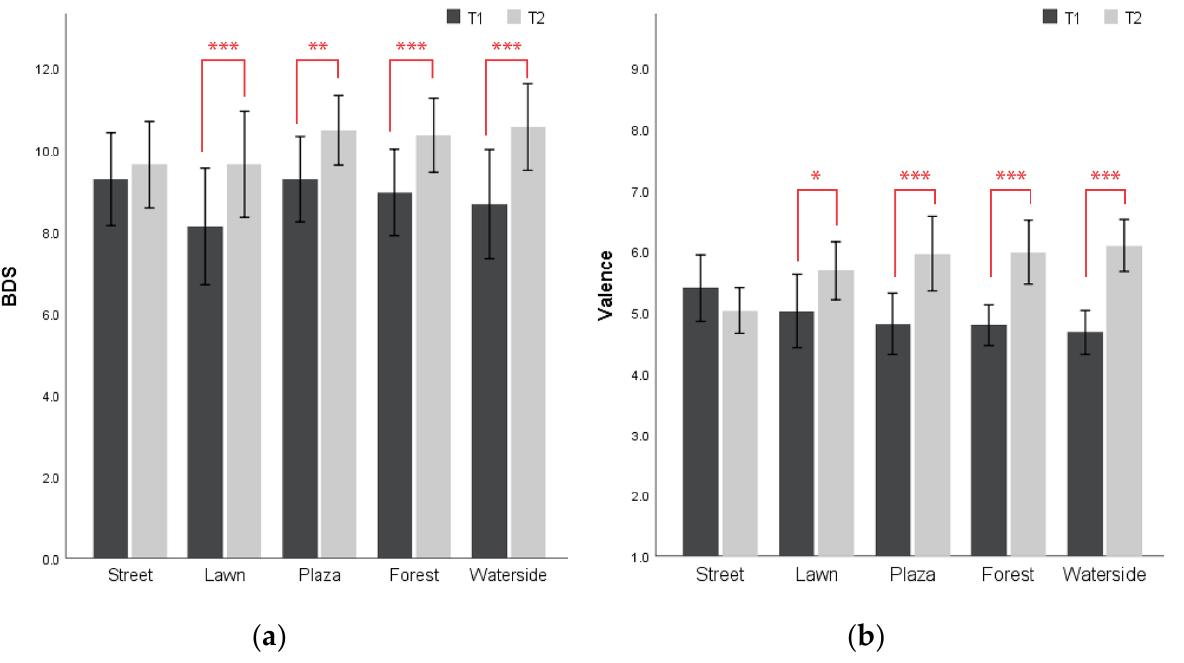
Figure 4. Changes in mean BDS score ( a ) and valence ( b ) in different environments during the experiment. Pairwise comparisons between pre-video (T1) and post-video (T2) in each environmental treatment are marked. * p < 0 .05, ** p < 0 .01, *** p < 0 .001.